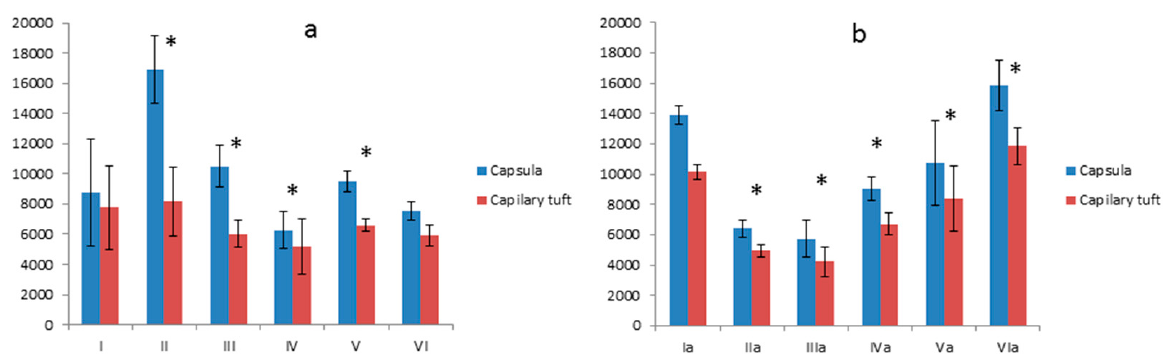
Figure 8. The capsule’s surface area and capillary tuft in kidneys of animals fed with regular diet ( a ) and fed with a high-cholesterol diet ( b ). Differences were statistically significant in respect to the control group at p = 0.05 (and signed by *). Vertical scale units expressed in µm.